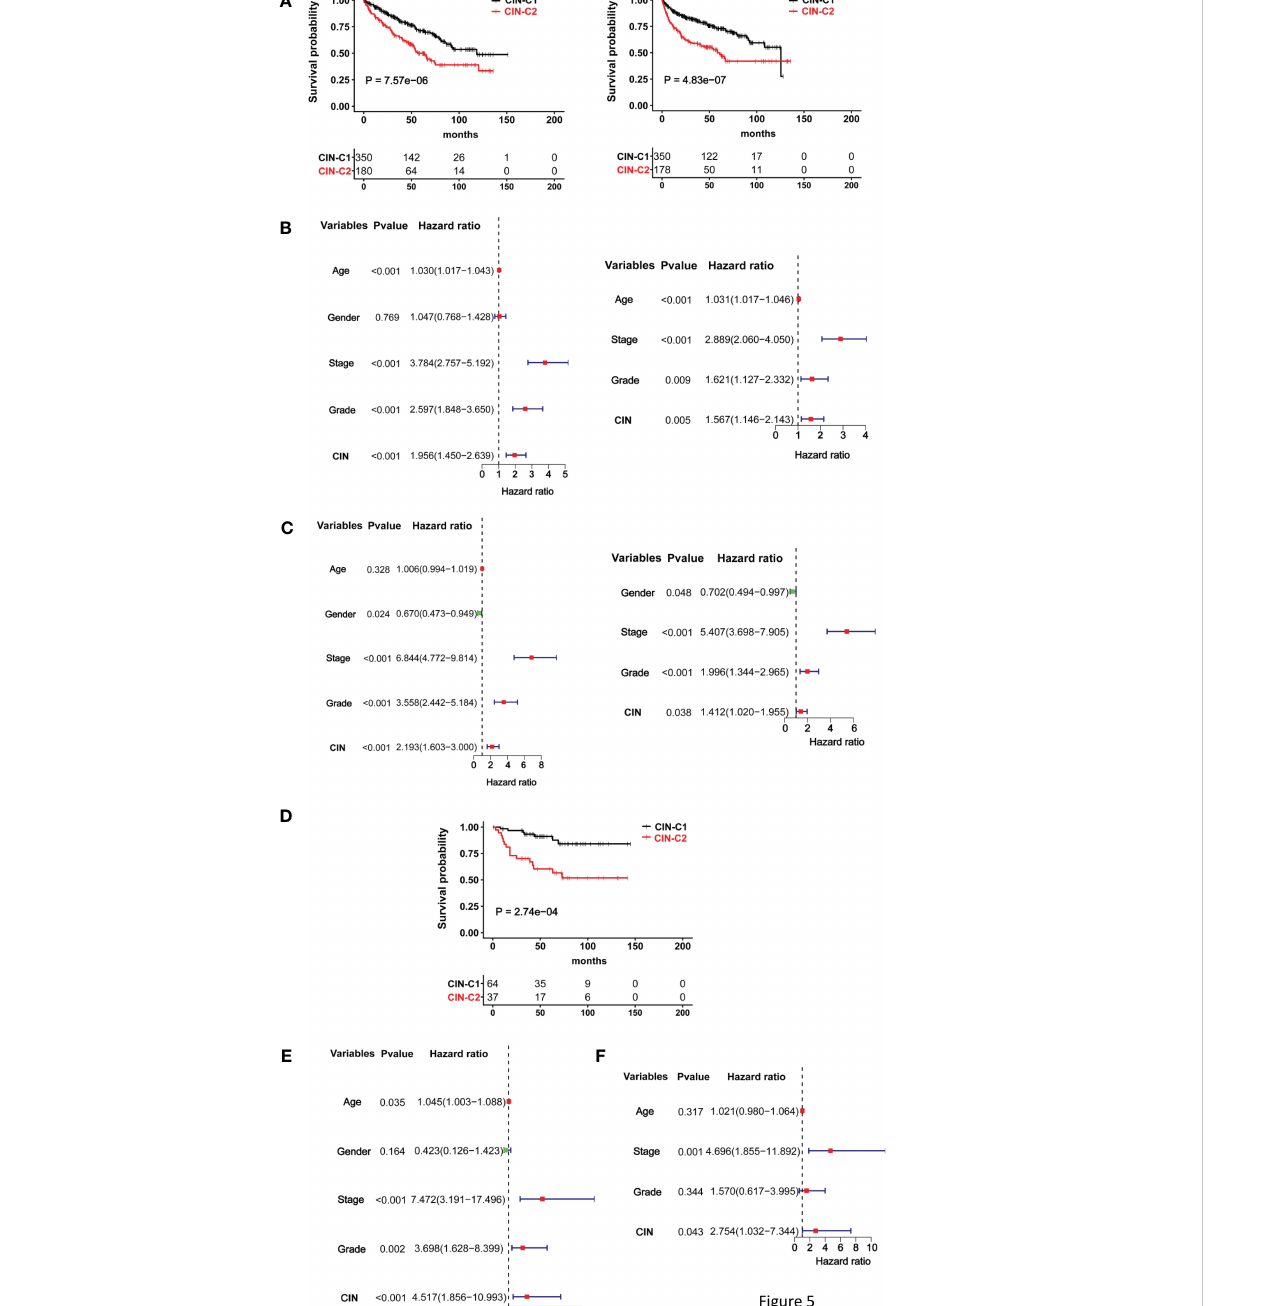
FIGURE 5 The CIN25 subtypes for survival prediction in ccRCCs. (A – C) The TCGA cohort analysis and (D, E) The E-MTAB1980 cohort analysis. (A) Signi fi cantly shorter overall and progression-free survival (OS and PFS) in the CIN25-C2 group. Left and right panel: OS and PFS, respectively. (B) Univariate and multivariate COX regression analyses of OS for the TCGA ccRCCs. (C) Univariate and multivariate COX regression analyses of PFS for the TCGA ccRCCs. (D) Signi fi cantly shorter OS in the CIN25-C2 group in the E-MTAB1980 cohort. (E, F) Univariate and multivariate COX regression analyses of OS for the E-MTAB1980